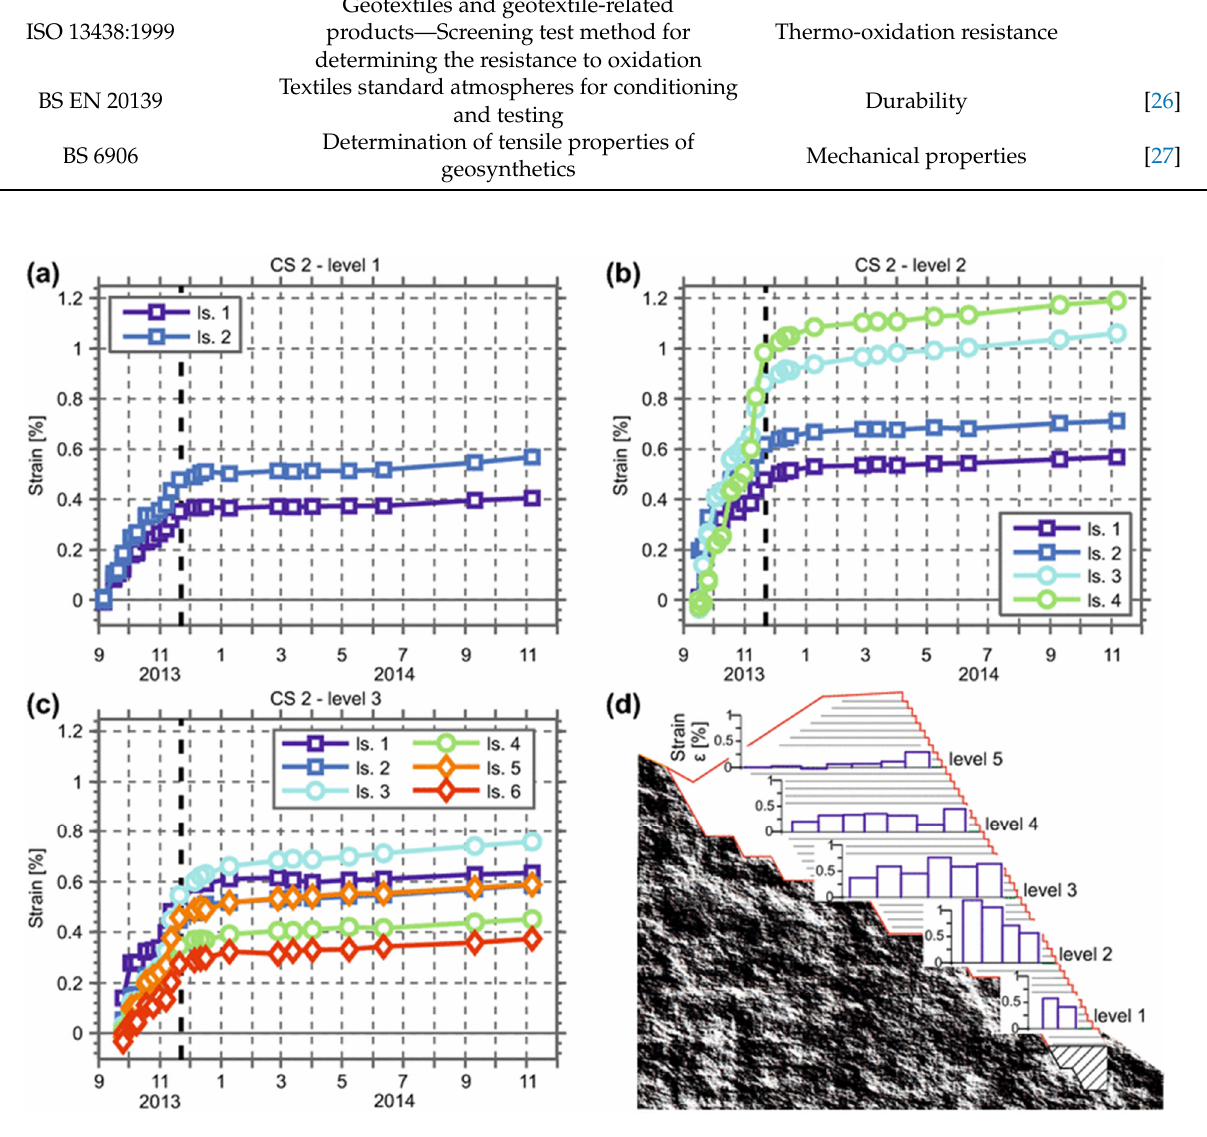
Figure 7. Strain evolution at various levels with the vertical bold dashed line representing the end of construction ( a – c ). In ( d ) is the accumulated strain inside the reinforced structure at different levels (Creative Commons CC BY, ref. [116]).